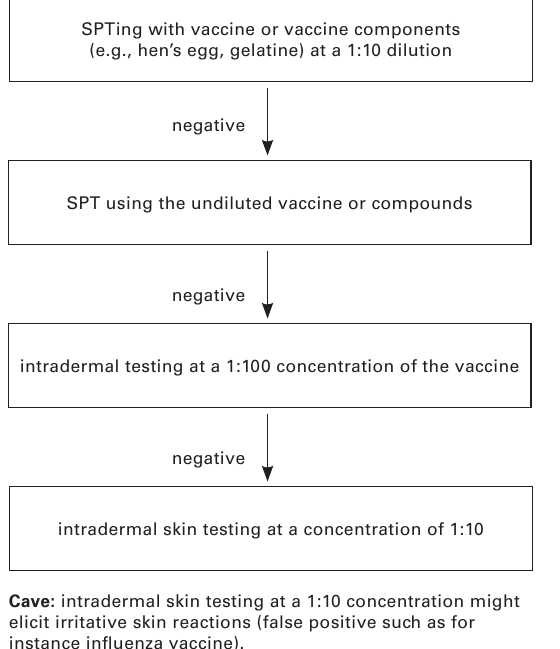
intradermal skin testing at a concentration of